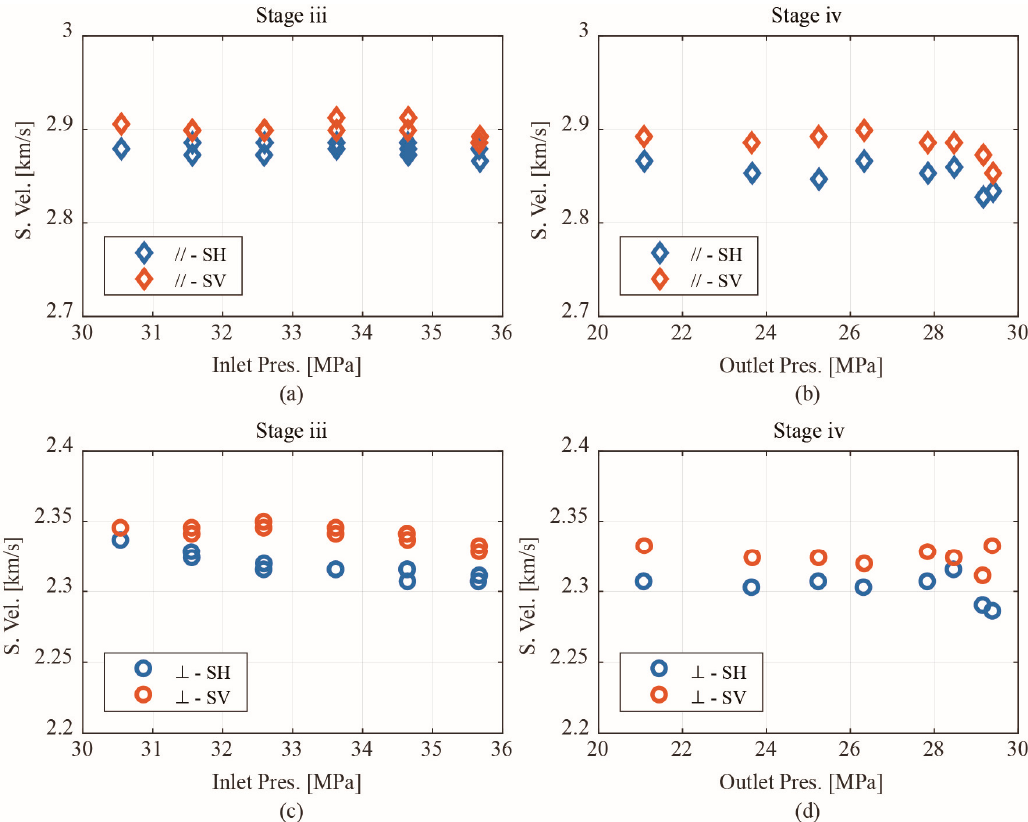
Figure 11. Comparison of measured v // − S and v ⊥− S in stages iii and iv. ( a ) v // − SH and v // − SV in Figure 11. Comparison of measured (cid:2204) //(cid:2879)(cid:1793) and (cid:2204) (cid:2884)(cid:2879)(cid:1793) in stages iii and iv. ( a ) (cid:2204) //(cid:2879)(cid:1793)(cid:1782) and (cid:2204) //(cid:2879)(cid:1793)(cid:1796) in stage iii; ( b ) v // − SH and v // − SV in stage iv; ( c ) v ⊥− SH and v ⊥− SV in stage iii; ( d ) v ⊥− SH and v ⊥− SV in stage iii; ( b ) (cid:2204) //(cid:2879)(cid:1793)(cid:1782) and (cid:2204) //(cid:2879)(cid:1793)(cid:1796) in stage iv; ( c ) (cid:2204) (cid:2884)(cid:2879)(cid:1793)(cid:1782) and (cid:2204) (cid:2884)(cid:2879)(cid:1793)(cid:1796) in stage iii; ( d ) (cid:2204) (cid:2884)(cid:2879)(cid:1793)(cid:1782) and (cid:2204) (cid:2884)(cid:2879)(cid:1793)(cid:1796) in stage stage iv.